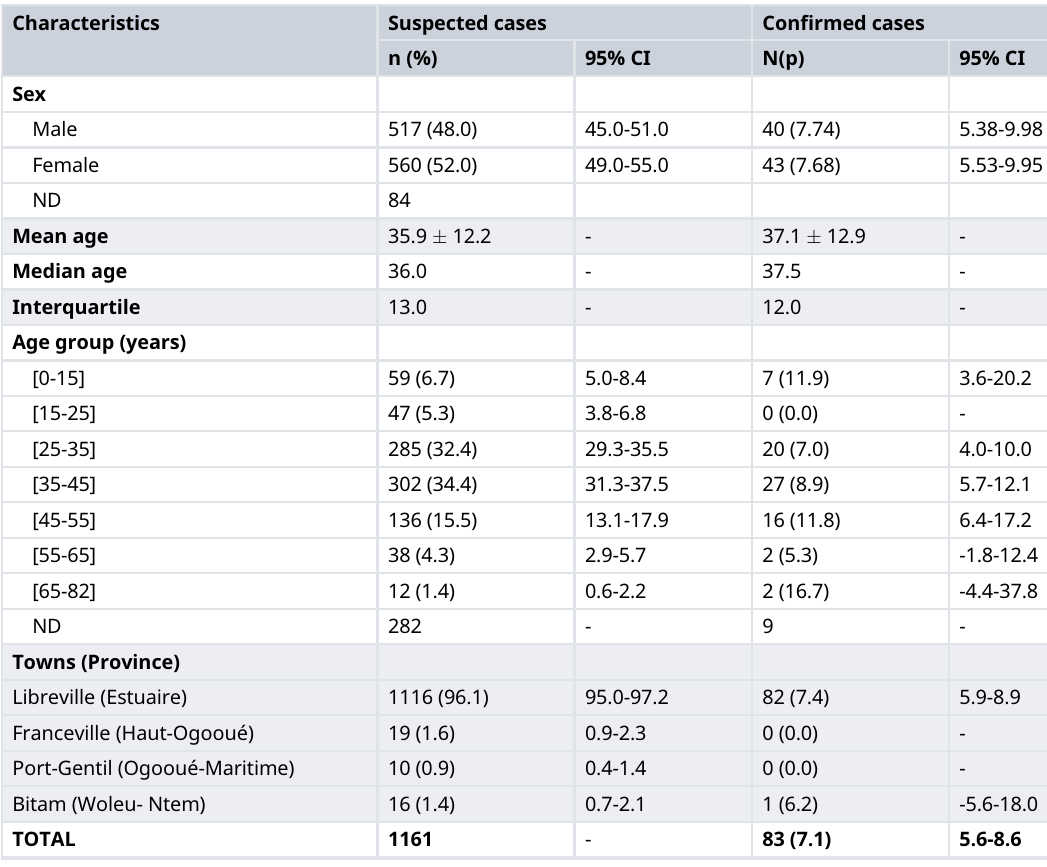
Table 1. Demographic characteristics of suspected cases and prevalence of confirmed COVID-19 cases.